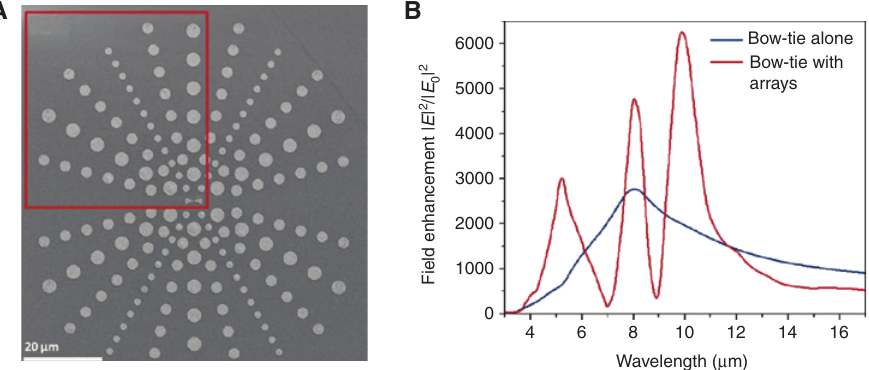
Figure 8: A multiresonant plasmonic system based on the optical coupling between LSP modes and grating diffraction modes [156]. (A) A single bow-tie nanoantenna (two sections of a disk with radius of 2.2 μ m, opening angle of 45 ° , and central gap of 100 nm), surrounded by three periodic arrays (with periodicities of 3.6, 5.7, and 7.2 μ m) of metallic disks (with diameters of 1.8, 2.85, and 3.6 μ m, respectively). All elements have a thickness of 70 nm and are deposited over a BaF substrate that is transparent in the mid-infrared regime. The bow-tie 2 antenna can couple with the metal particle arrays grating diffraction modes. (B) Simulated electric field intensity enhancement spectrum at the center of the bow-tie antenna at the center of the grating system (red curve) as well as in the isolated state (blue